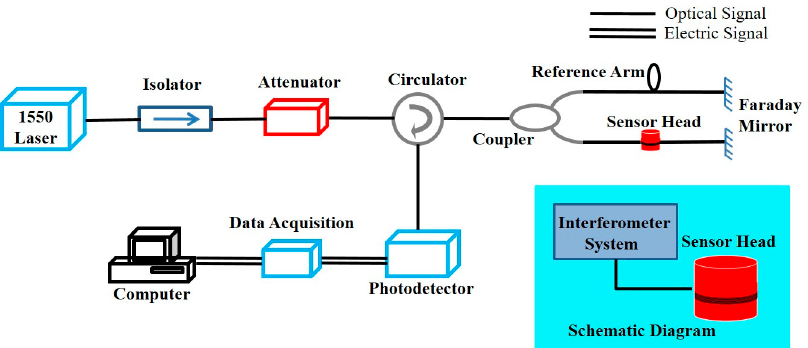
Figure 2. Experimental setup of the Michelson interferometer-based fiber sensing system, the inset shows its equivalent diagram.